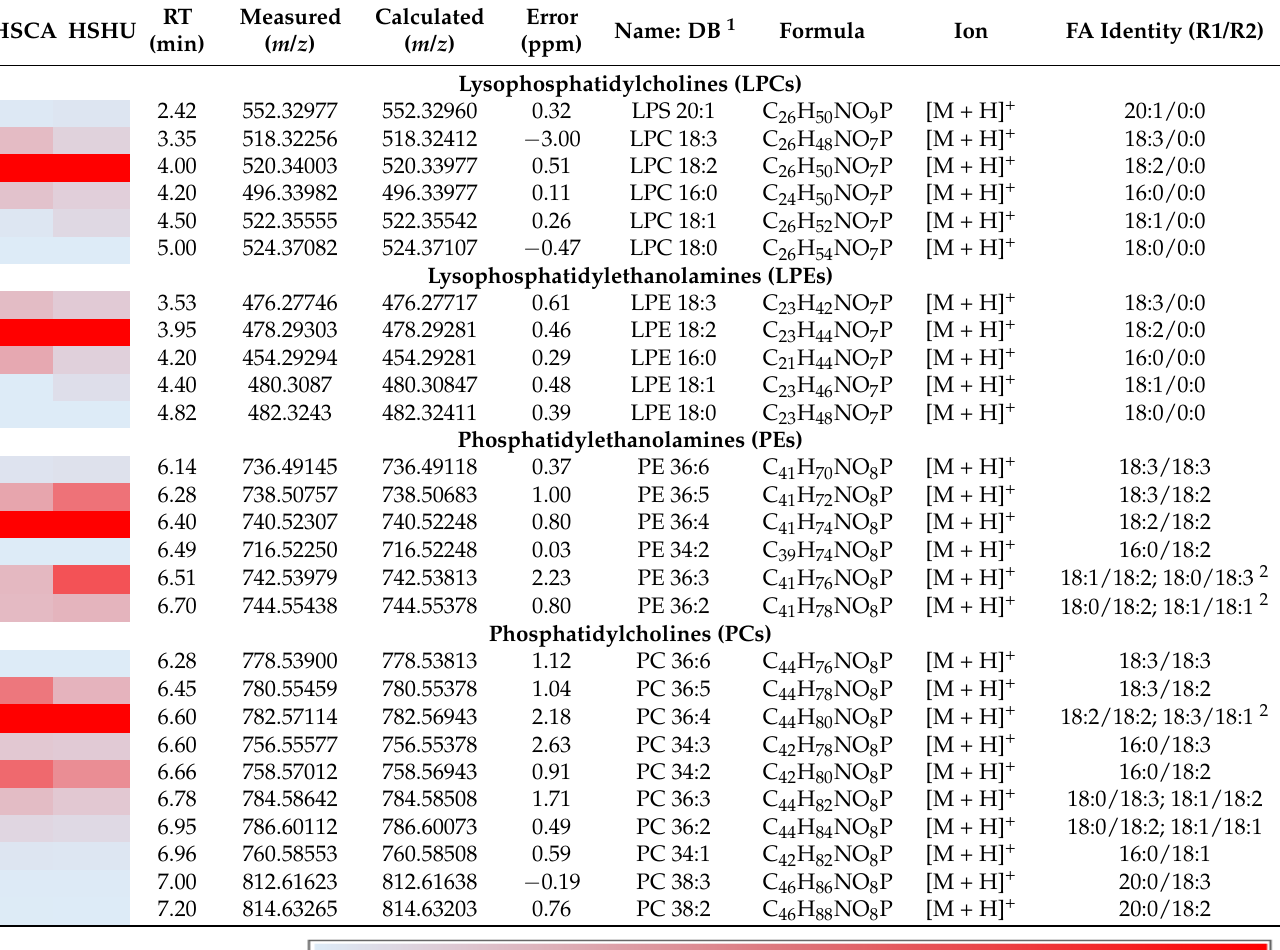
Table 3. Heat map of LPCs, LPEs, Pes, and PCs identified in polar lipid fraction (SPE-MeOH fraction) of hemp cake (HSCA) and hemp seed hulls (HSHU).